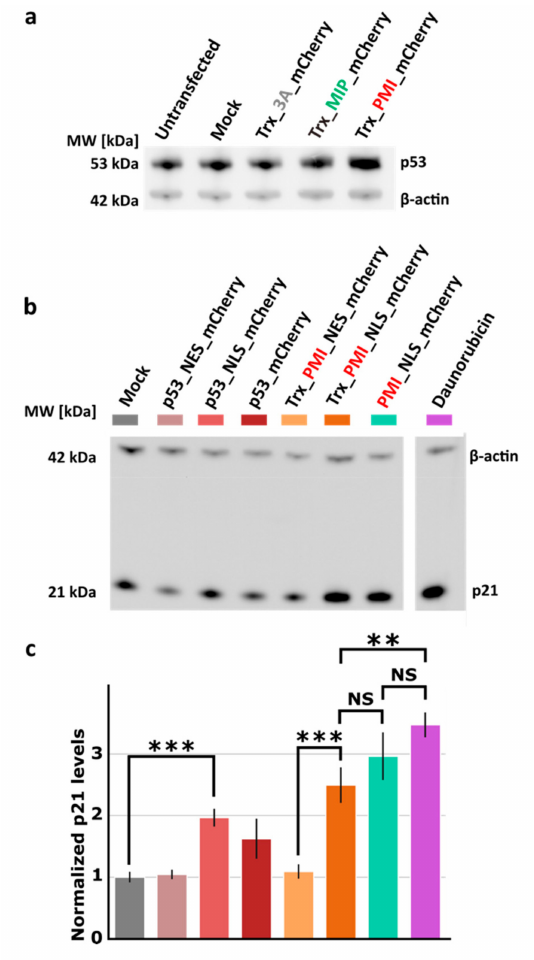
Figure 1. The p53-MDM2 / MDMX inhibitor (PMI) peptide stabilizes p53 in HCT116 cells in a localization-dependent manner. (a), (b) Western blot showing the levels of p53 (a) and p21 (b) in HCT116 cells transfected with the indicated constructs. Mock indicates cells transfected with empty pcDNA3.1( + ). β -actin was used as loading control. ( a ) This experiment was conducted once. ( b ) Daunorubicin was added at 0.5 µ M 8 h after transfection. Cells were collected for Western blot analysis after 24 h. A lane with a sample not relevant to this study was cut from the image and is shown as a white space. ( c ) Bar plot showing the quantification of two independent Western blots with samples as in (b). Data indicate mean ± standard deviation. Color code as in (b). NS p ≥ 0.05, ** p < 0.01, *** p < 0.001, t